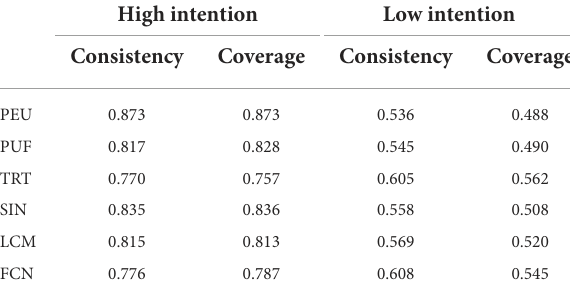
TABLE 8 Necessary conditions for higher intention to use the smart wearable payment device.